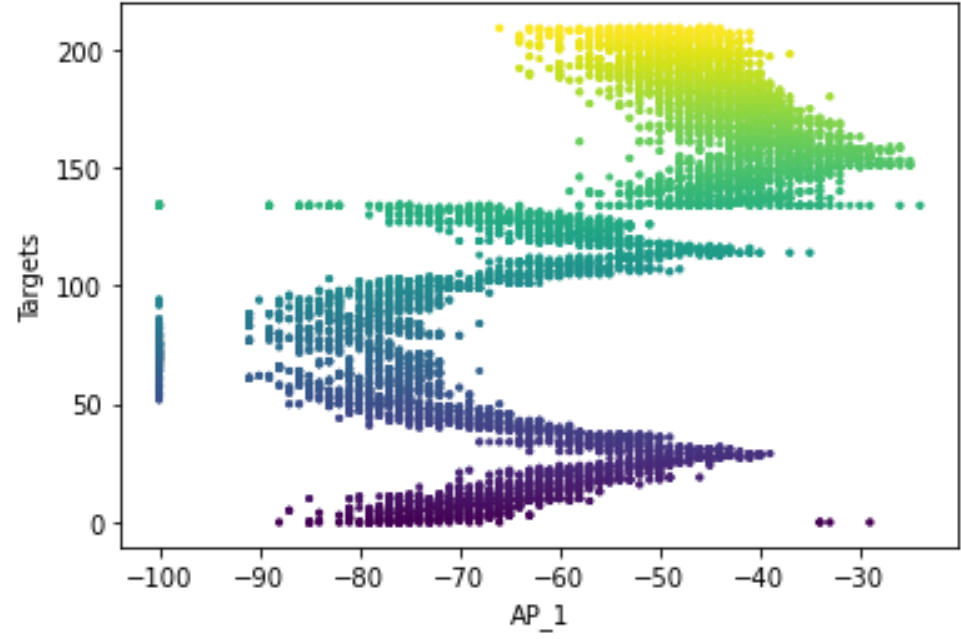
Figure 5. Distributions of RSS for Wi-Fi AP1 with their corresponding targets for dataset A.